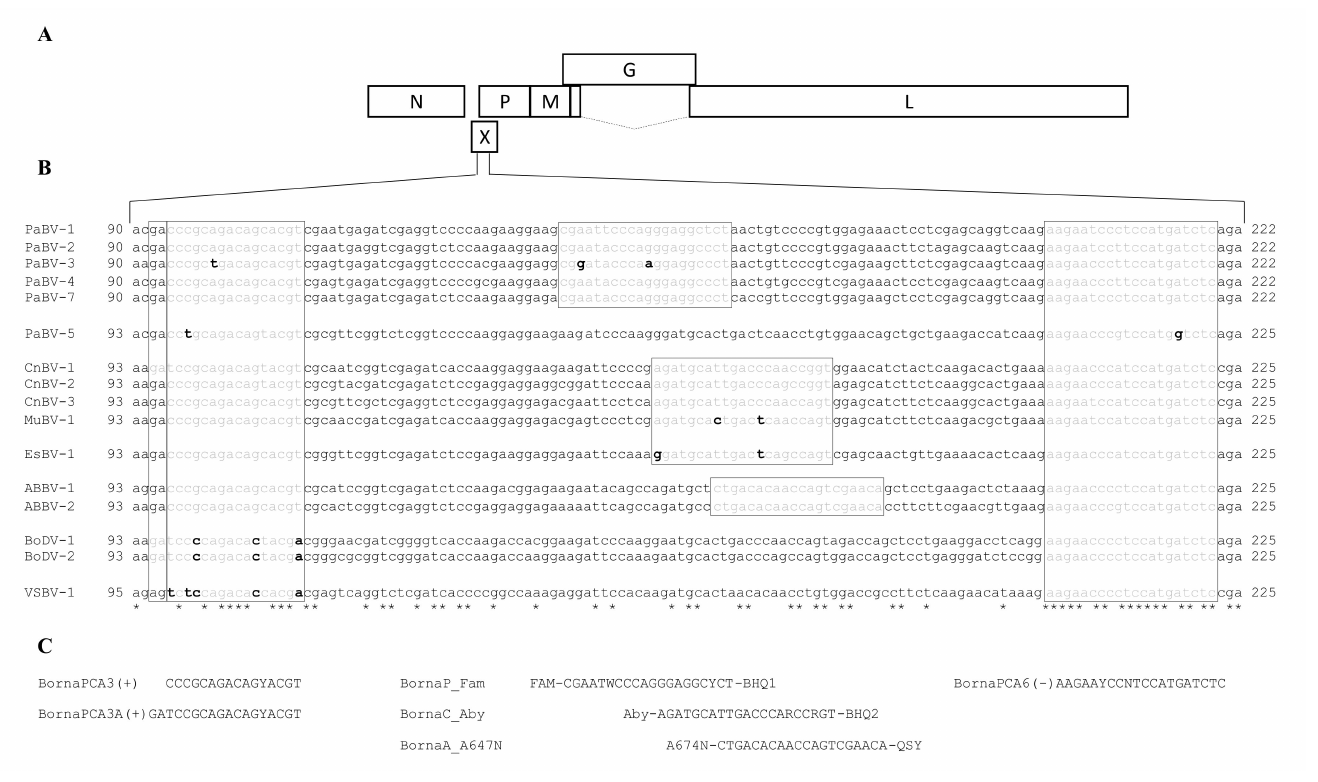
Figure 2. Primer and probe design. ( A ). Schematic presentation of the orthobornavirus genome. ( B ). Alignment of the partial orthobornavirus X/P gene sequences (positions 90/93 to 222/225). Boxes: sequences corresponding to the primer and probe binding regions; grey: nucleotides matching the primer/probe sequence; black, boldface: nucleotides mismatching with the primer/probe sequence. PaBV-6 and PaBV-8 are not included in this alignment, since no X gene sequences are available for these viruses. ( C ). Primer and probe